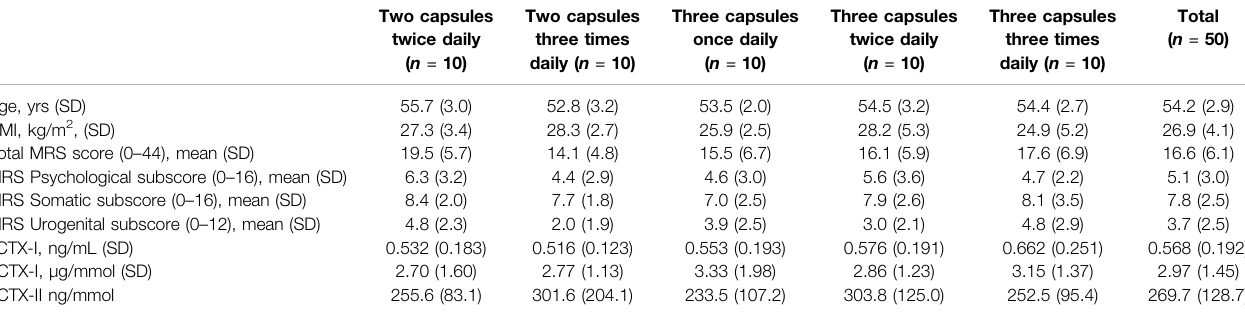
TABLE 1 | Baseline demographics, intention-to-treat